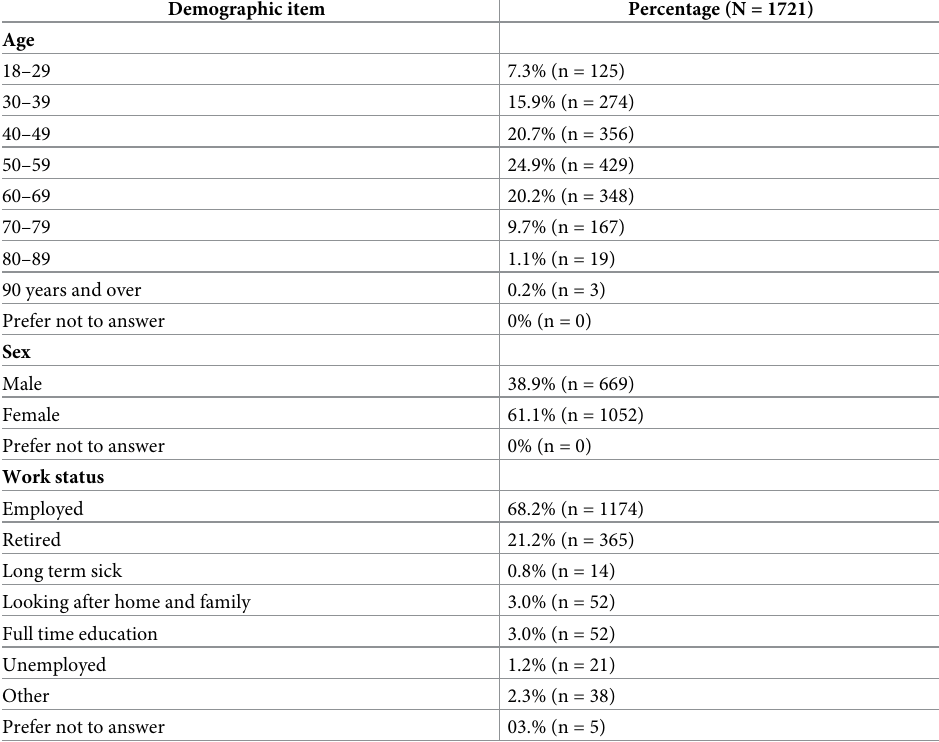
Table 1. Profile of patients who have contributed PROMs data at